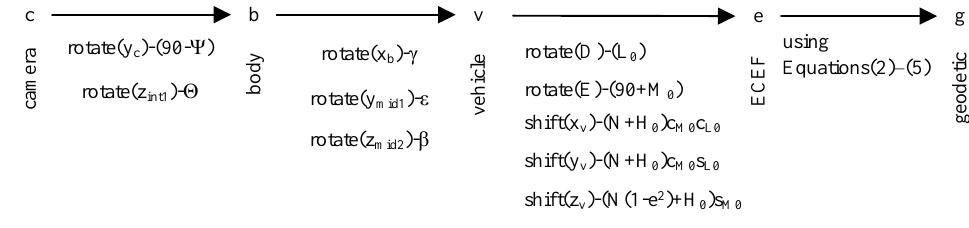
Figure 7. Coordinate transformation process of multi-target geo-location system.